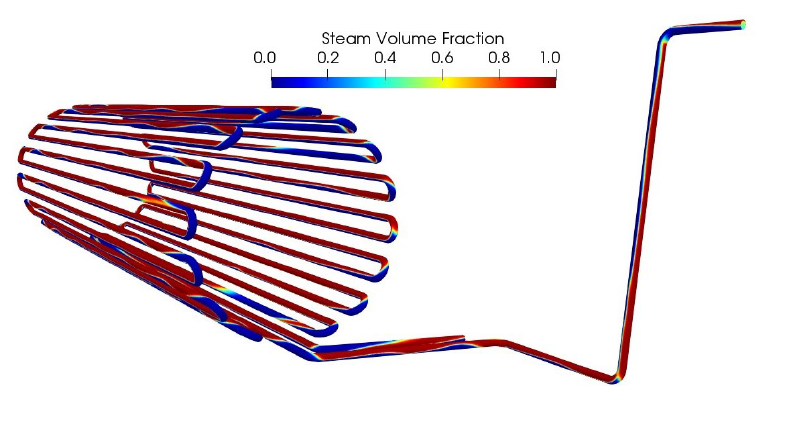
Figure 27. Vapor phase fraction contour within the radiant tubes-whole tubes.